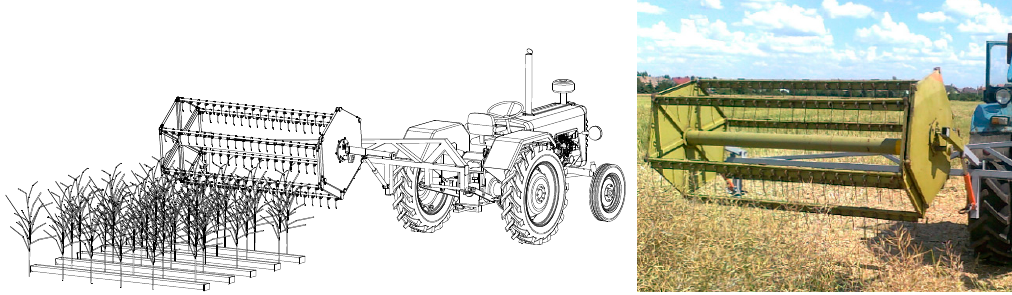
Figure 2. Combine harvester reel mobile stand: schematic view and in the field.